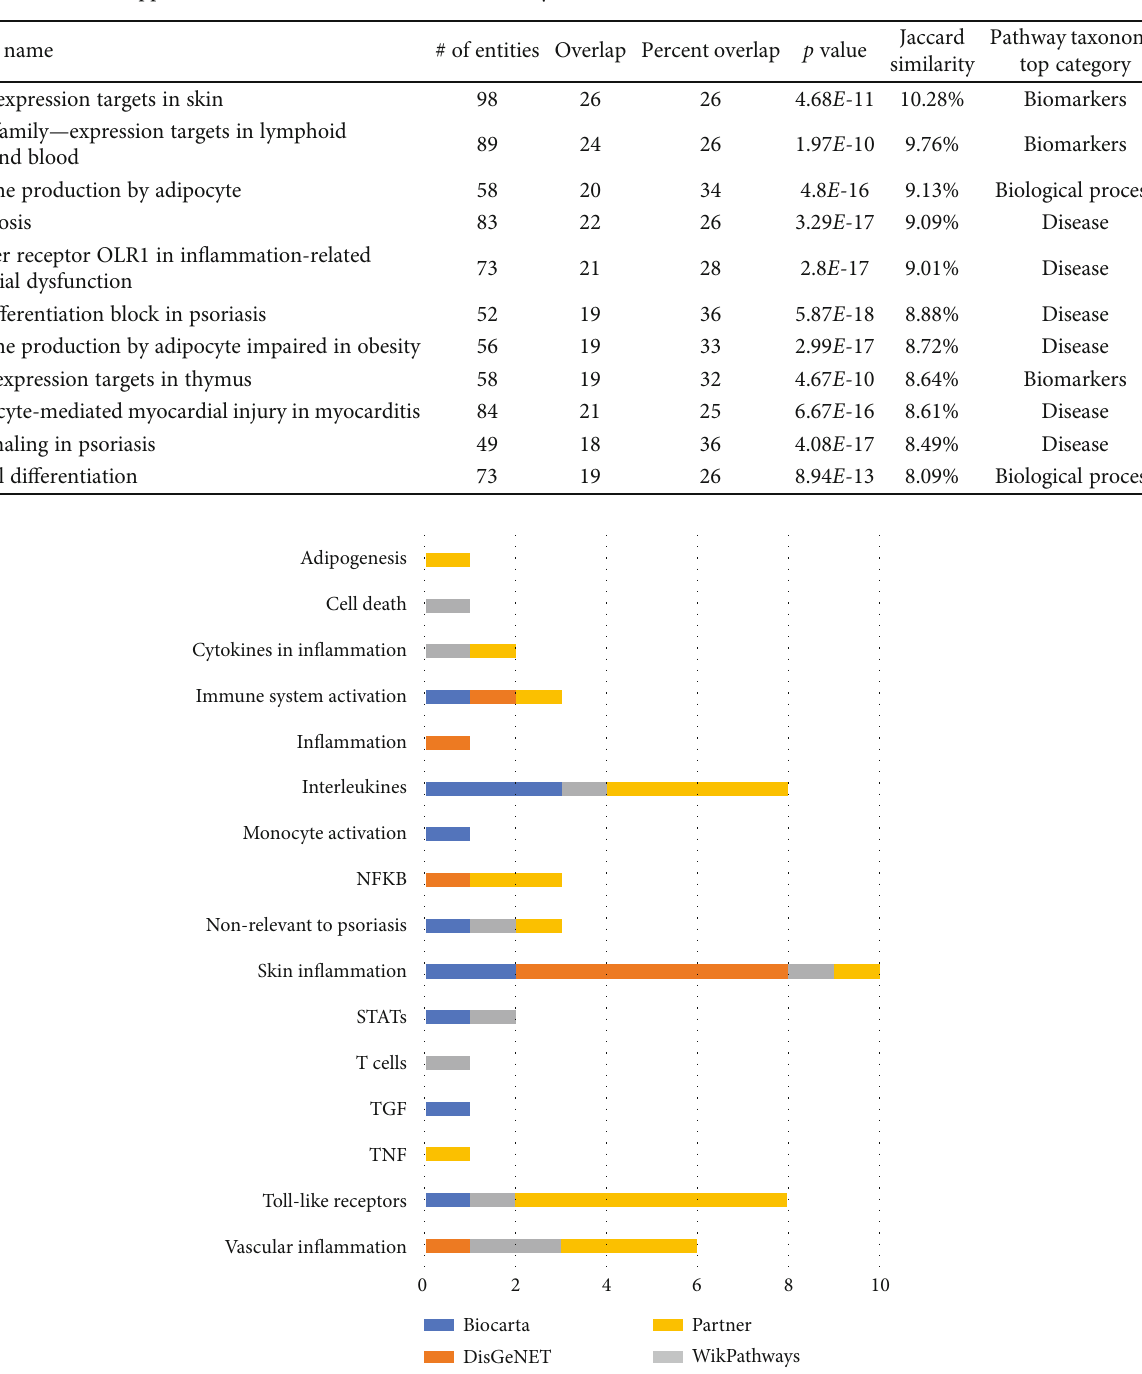
Figure 3: Comparison of results of pathway analysis (GSEA) with di ff erent sources for PPAR γ -downregulated signaling associated with psoriasis. Results were calculated with the Enrichr tool. Numbers are for the sum of pathways in each category. Di ff erent sources are highlighted with blue (Biocarta database), grey (Partner database), orange (DisGeNET), and yellow